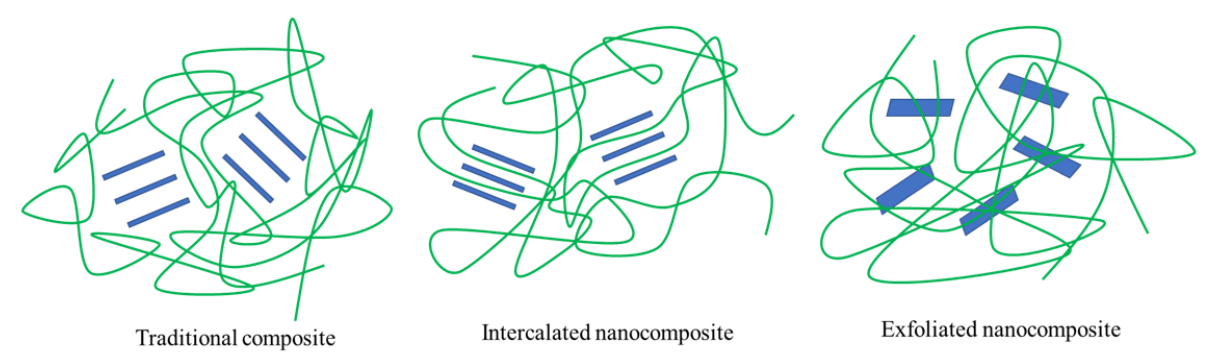
Figure 4. Schematic of three structures of layered silicate nanocomposites.